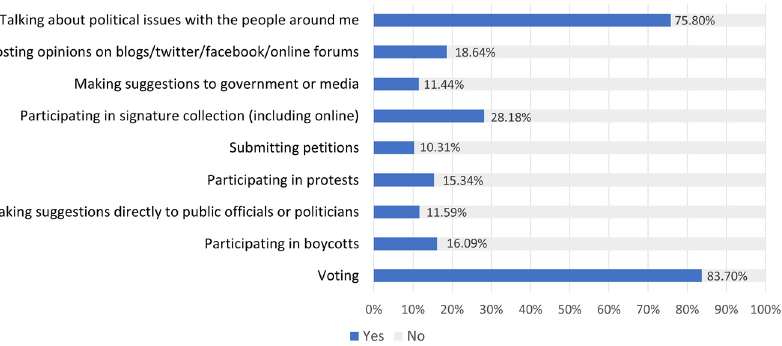
Figure 2: Percentage of the respondents who have engaged in political activities and